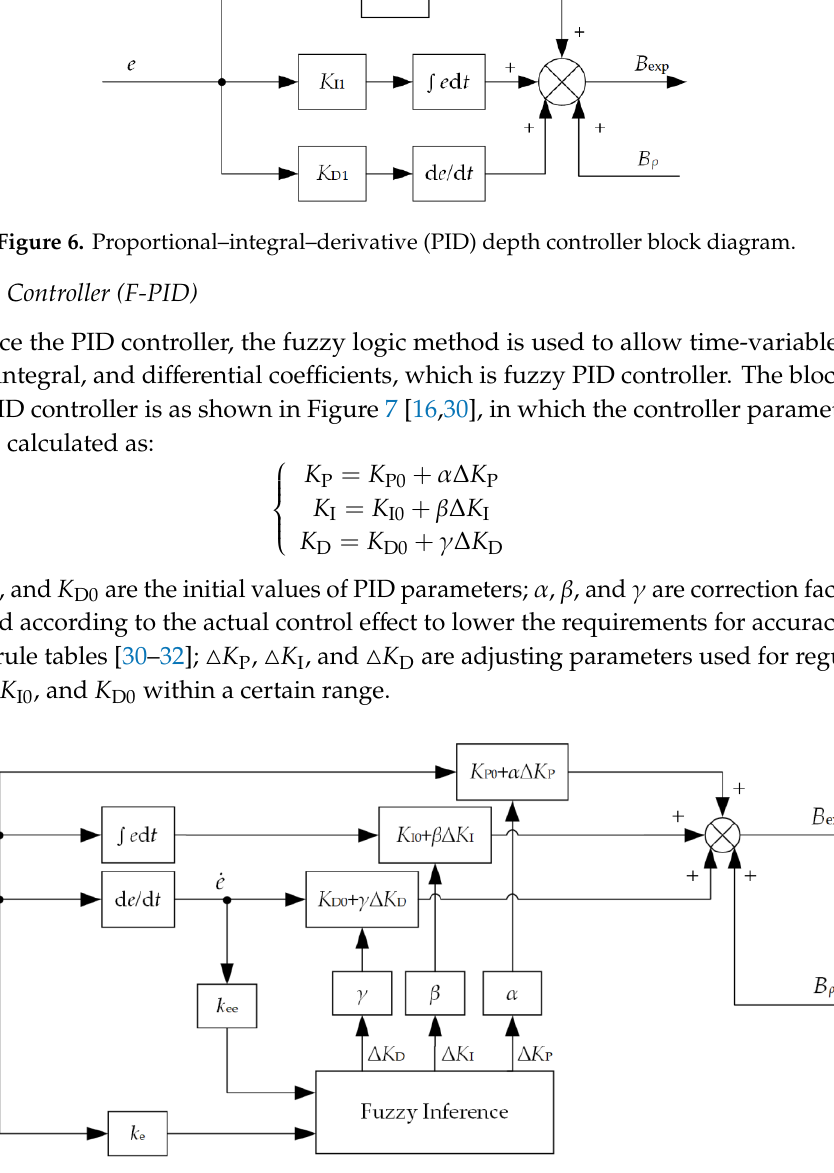
Figure 7. Fuzzy PID depth controller block diagram ( k e and k ee are adjustment for fuzzy inference inputs; α , β , and γ are correction factors for fuzzy inference outputs).